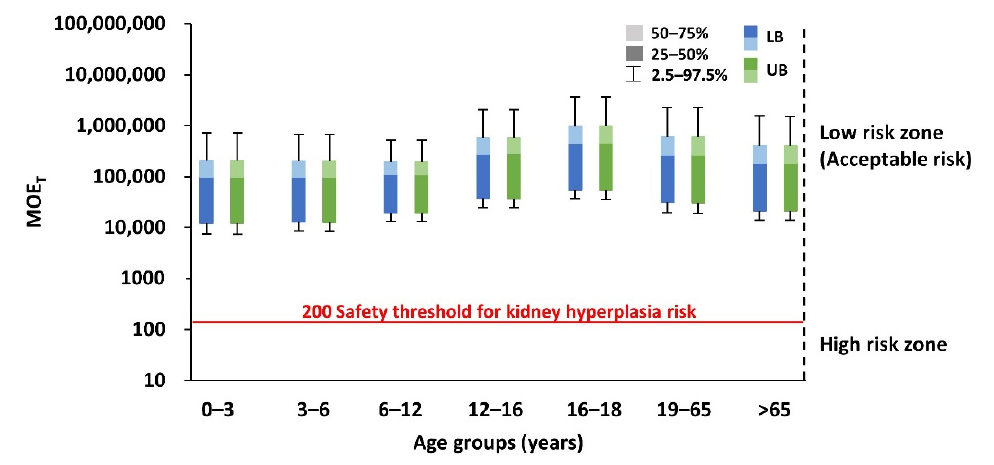
Figure 6. Combined MOE (MOE T ) of BP, 4-MBP, and PBZ in different age groups.